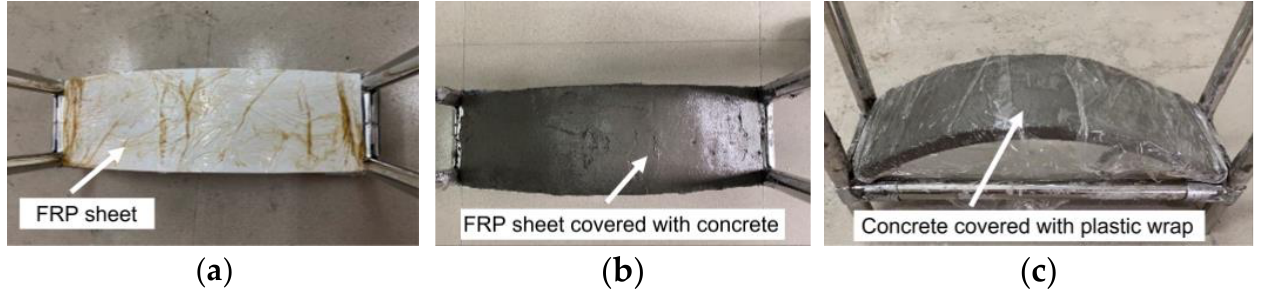
Figure 4. Preparation process of traditional concrete shell structure: ( a ) FRP sheet fixed on the self-made scaffold; ( b ) FRP sheet covered with concrete; ( c ) Concrete covered with plastic wrap.